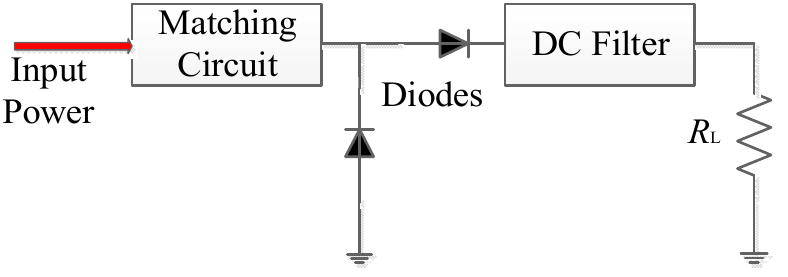
Figure 4. Schematic of the voltage doubling rectifier.